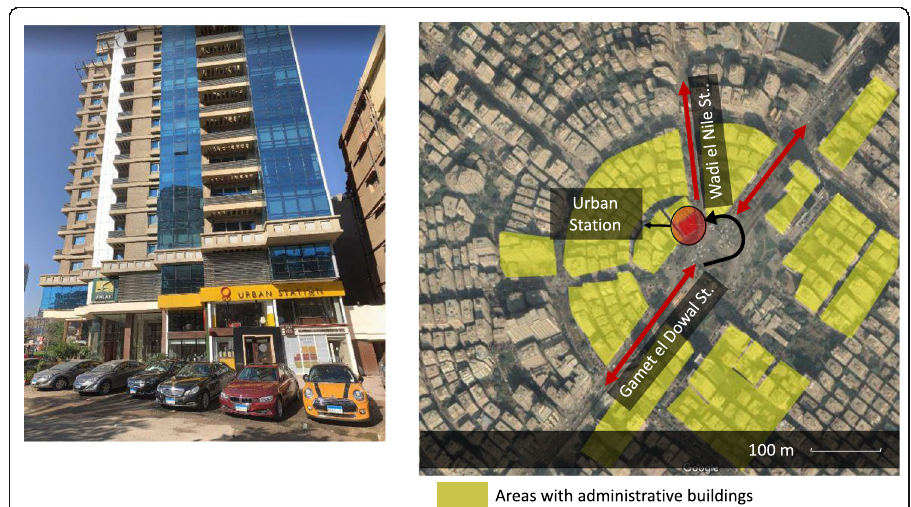
Fig. 9 Administrative building (on the left) accommodating Urban station co-working space; situated in an administrative area on Gamet el Dowal and Wadi el Nile Street (on the right) in Mohandessen area near Dokki area, in Cairo. Map source https://www.google.com/maps , elaboration by